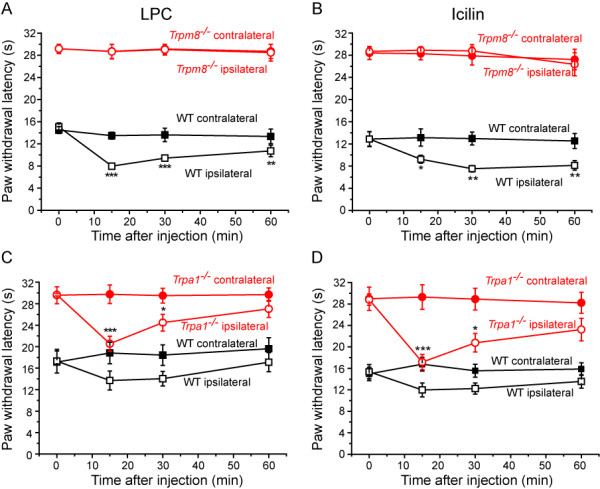
Cold hypersensitivities evoked by icilin and LPC are absent in Trpm8-/- mice but retained in Trpa1-/- mice. Effects of intraplantar administration of either 60 μg LPC (A) or 100 μg icilin (B) on cold withdrawal latencies in lightly restrained Trpm8-/- and wild-type littermate mice. Neither compound had an effect on withdrawal latency for the injected (ipsilateral) paw in Trpm8-/- mice. Both compounds reduced the ipsilateral paw withdrawal latencies in wild-type littermates, but had no effect on withdrawal latencies for the uninjected (contralateral) paw. Intraplantar LPC (C) or icilin (D) reduced paw withdrawal thresholds for ipsilateral paws in both Trpa1-/- and wild-type littermate mice. Note that a greater cold hypersensitivity was seen in Trpa1-/- than in wild-type mice. Data show mean ± SEM for 6 mice/group. * p < 0.05, ** p < 0.01, *** p < 0.001 vs relevant predose values. † p < 0.05, †† p < 0.01 for contralateral-ipsilateral difference in wild-type mice.